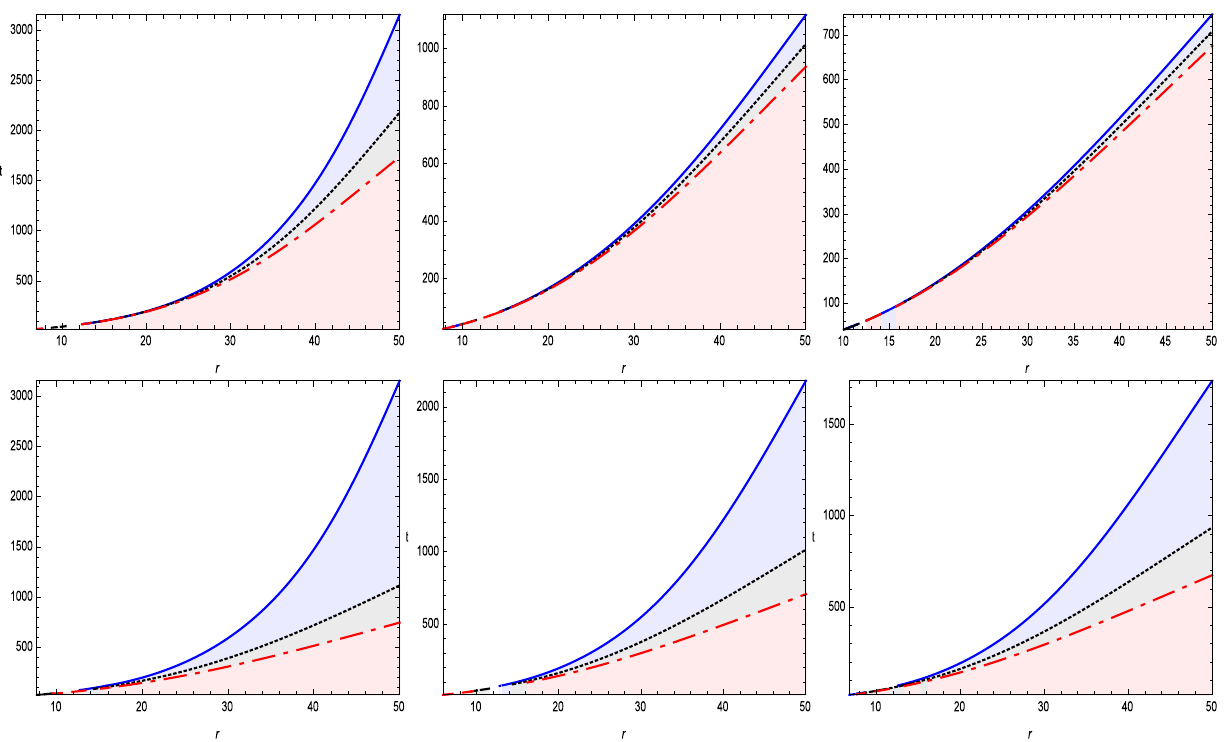
Fig. 7 Shows the behavior of t for the different possible values of a and q . The left panel of the first row represents q = 0 . 007 (blue), q = 0 . 008 (black), and q = 0 . 009 (red) with a = 0 . 93. The middle panel of the first row represents q = 0 . 007 (blue), q = 0 . 008 (black), and q = 0 . 009 (red) with a = 0 . 95. The right panel of the first row represents q = 0 . 007 (blue), q = 0 . 008 (black), and q = 0 . 009 (red)